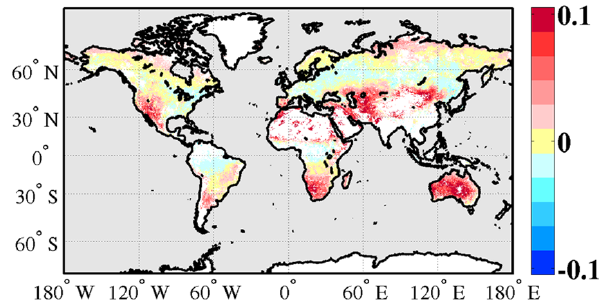
Figure 5. Difference between the monthly aggregated ADV- retrieved surface reflectances at 659 and 555nm for June